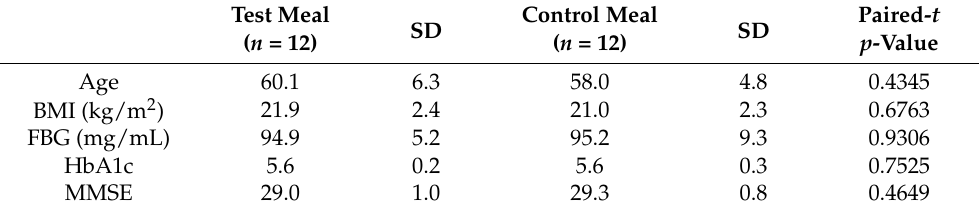
Table 7. Comparison between test and control meals for human intervention test items.